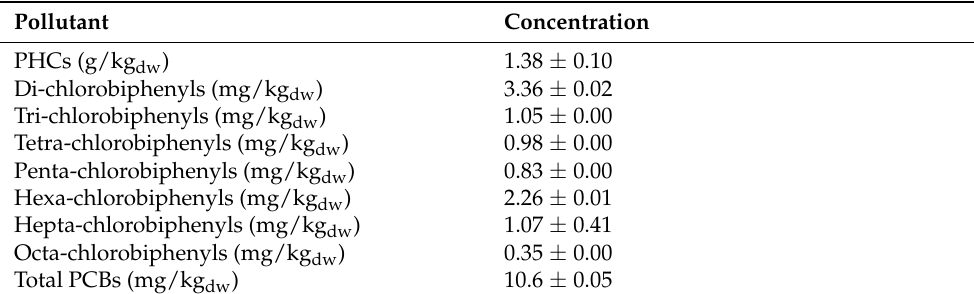
Table 1. Concentration of petroleum hydrocarbons (PHCs) and polychlorinated biphenyls (PCBs) in the Mar Piccolo